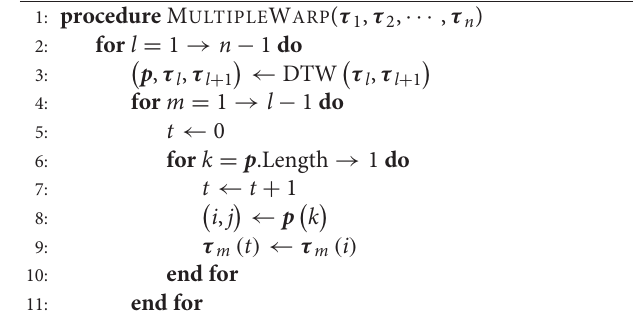
Algorithm 3 Warping for Multiple Trajectories